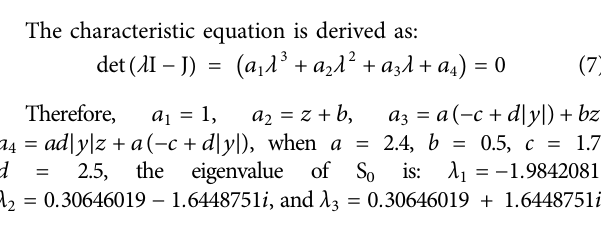
Frontiers in Physics |